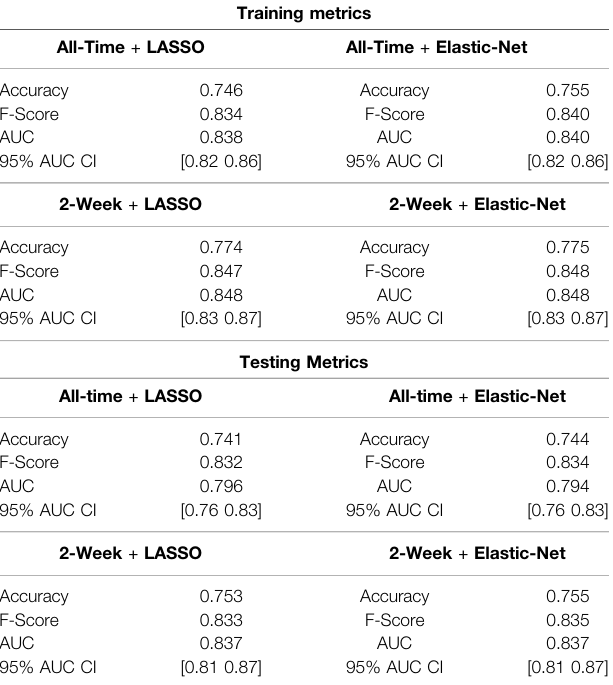
TABLE 2 | Model metrics Evaluation of four models (LASSO and Elastic-Net with patient ’ s conditions information from two timeframes) while training and testing (i.e., holdout) data set. For each model, the accuracy, F-Score, and AUC with 95% CI using DeLong ’ s method (DeLong et al., 1988) are shown. The accuracy metric indicates the percent of correct predictions. F-score is the harmonic mean of precision and recall. Area under receiver operating curve (AUC) is the area under the curve resulting from plotting the true positive against the false positive